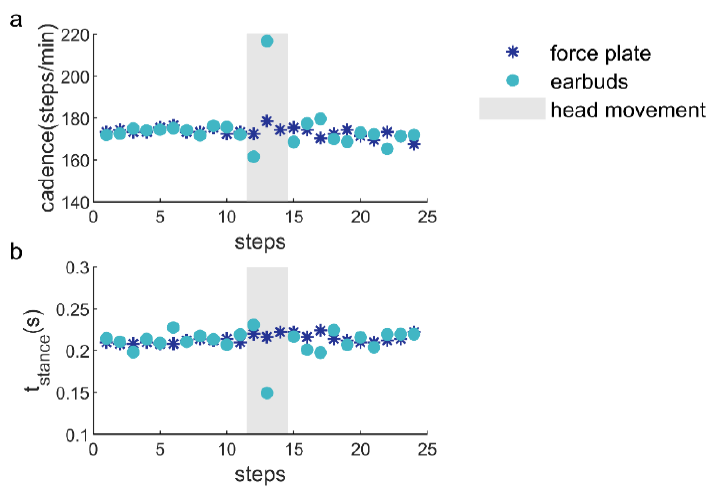
Figure 7. Example of a representative part of the instructed head-movement trial for a single participant for the head-movement condition ‘shake’, with step-based estimates of cadence ( a ) and stance time ( b ), over which the means were calculated. The shaded area represents steps with head shakes.